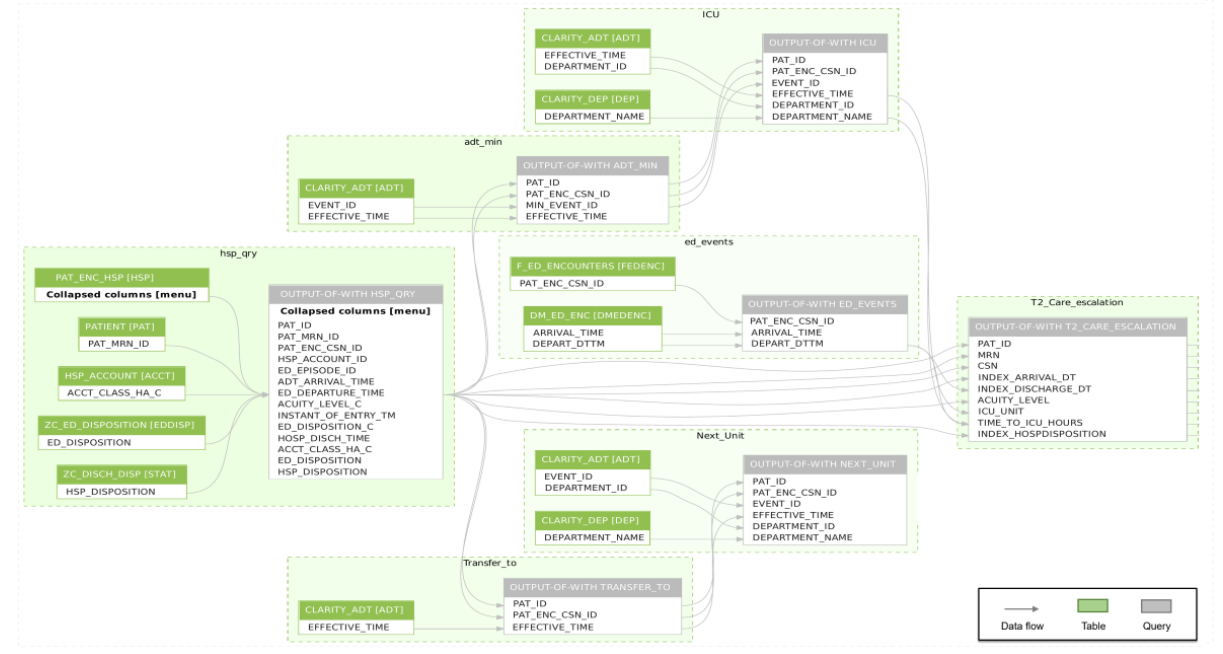
Figure 4. Emergency department patients’evaluation against each trigger is done upon executing these queries on each electronic health record database. This figure is an example relational database schema on how relevant electronic health record–based predictive factors are being invoked from multiple database tables to build up a record of escalations in the care condition, denoted by trigger-2. Abbreviations in the figure represent arbitrary variable names as